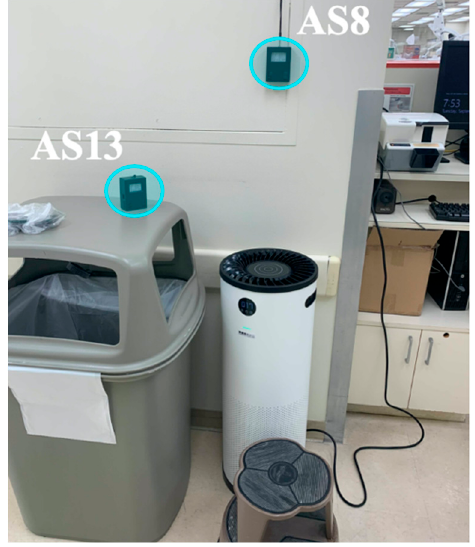
Figure 4. Photograph of the Surgically Clean Air Jade air purifier with three sensors (one sensor not in the field of view, located on the floor, in front of the air inlet of the filtration unit) to monitor the effects of the HEPA-filter-equipped air purifier.